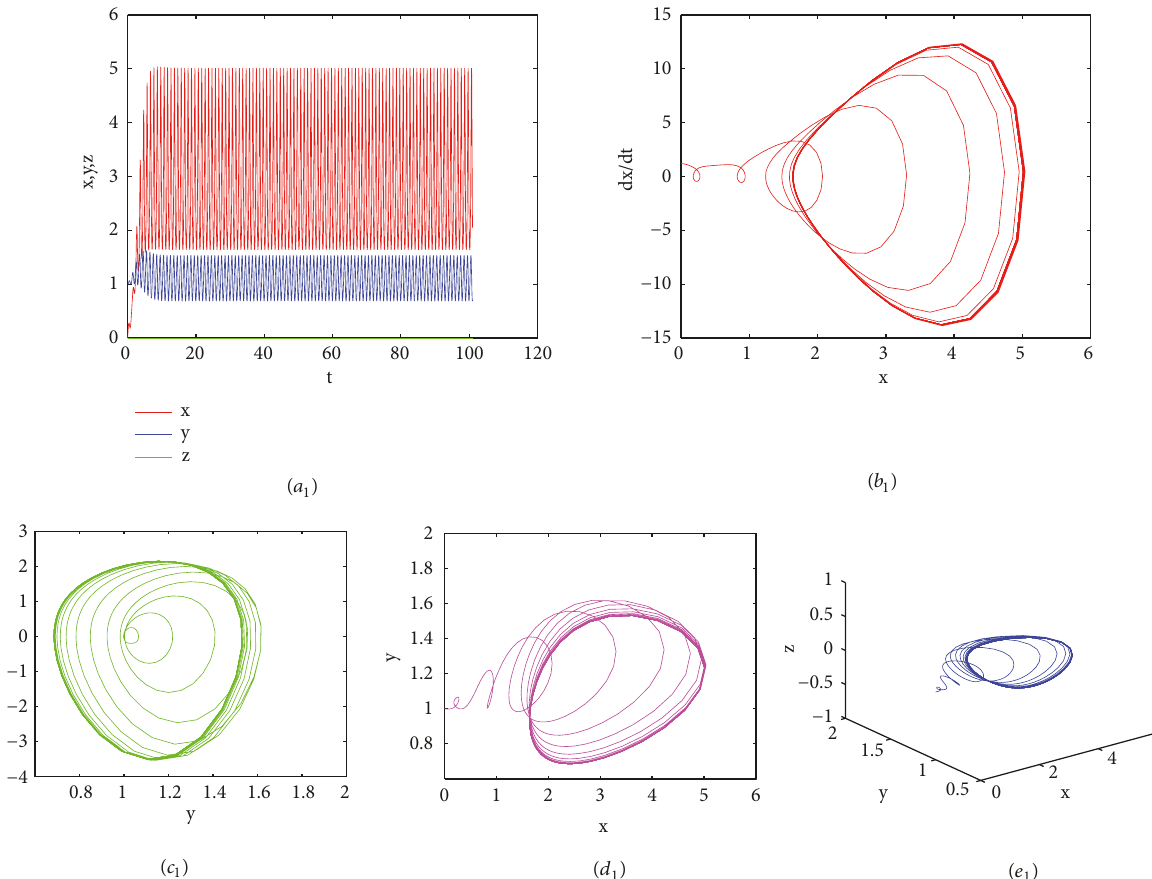
Figure 10: The results of Experiment 6: (𝑎 1 ) time series plot of 𝑥, 𝑦,𝑧 ; (𝑏 1 ) phase diagram of 𝑥 ; (𝑐 1 ) phase diagram of 𝑦 ; (𝑑 1 ) projected on the (𝑥,𝑦) -plane; (𝑒 ) on the three-dimensional 1